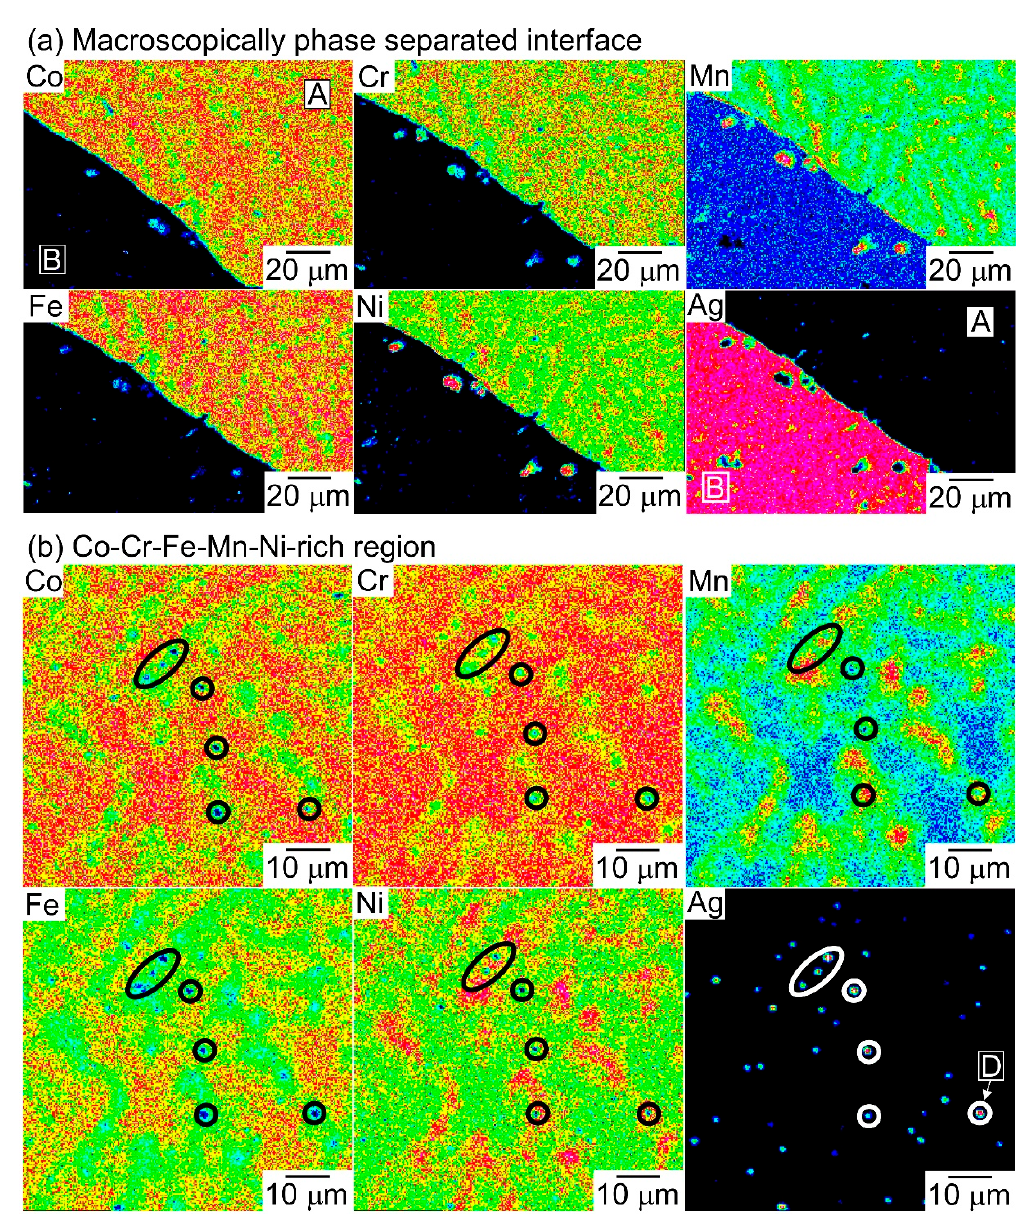
Figure 5. Element mapping of the arc-melted ingots in the equiatomic AgCoCrFeMnNi HEA with a macroscopic phase-separated structure using electron probe microanalysis-wave dispersive spectroscopy (EPMA-WDS). ( a ) Element mapping focusing on the macroscopically phase-separated interface, ( b ) element mapping focusing on the Co-Cr-Fe-Mn-Ni-rich region (index A in Figure 5a).